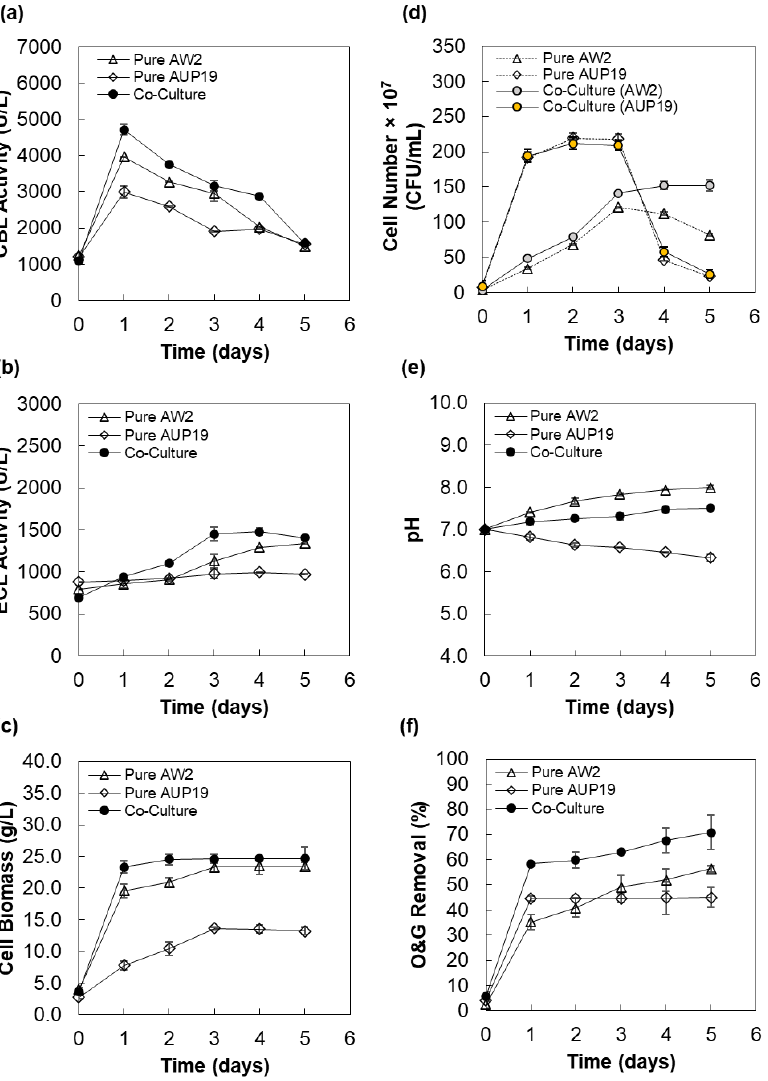
Figure 5. Time course of the blended oily wastes valorization into CBLs ( a ), ECLs ( b ), CBM ( c ), and the profile of cell number ( d ), pH changes ( e ), and O&G removal ( f ) by a pure culture of M. spicifer AW2, pure culture of S. hominis AUP19, and co-culture of M. spicifer AW2 and S. hominis AUP19 under the optimized conditions of POME50 with the addition of 2.08% ( v / v ) waste frying oil, 1.72.0% ( w / v ) ammonium sulfate, 0.1% ( w / v ) Gum Arabic, initial pH at 7.0, the incubation time for 5 days at room temperature (30 ± 2 °C), shaking at 150 rpm, inoculum size at 10% ( v / v ) with the yeast – bacterium ratio at 1:1.